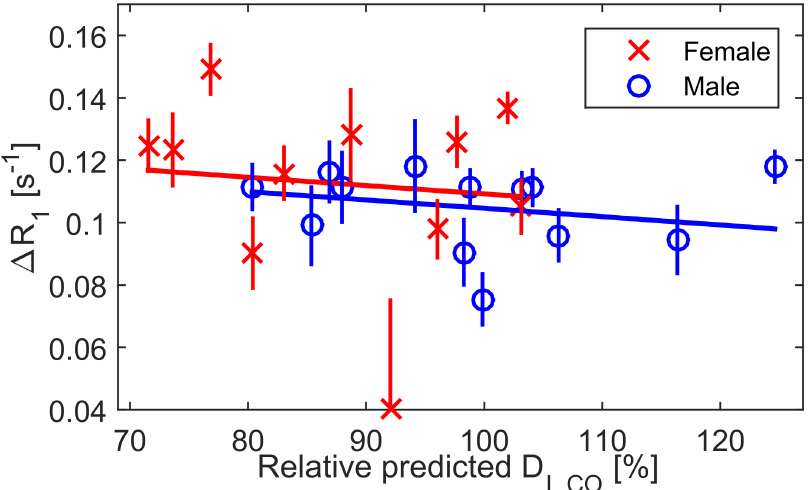
Fig 3. Plot of OE as a function of diffusing capacity. Linearregression of Δ R 1 as function of relative predicted D L,CO and sex for n = 24 participants, whole model R 2 is 0.05 at p = 0.57. Neither sex nor D L,CO is a significantpredictor in this model. Error bars represent the coefficient of variationin repeatedmeasurements of R 1